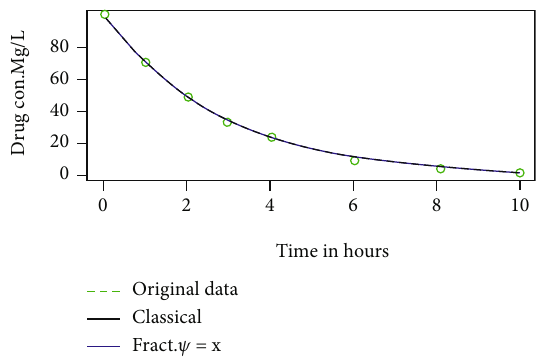
Figure 4: Original, classical, and fract. ψ ð x Þ = x .